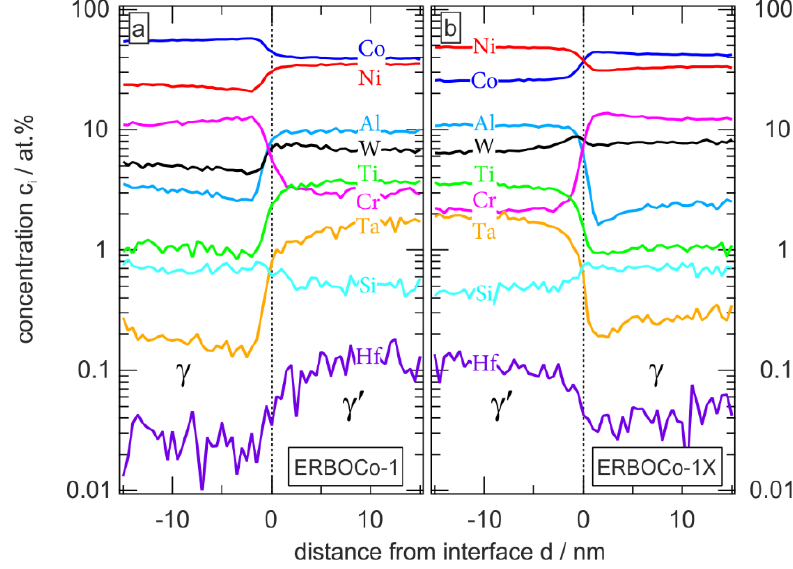
(cid:48) interfaces shown in Figure 4a,b.